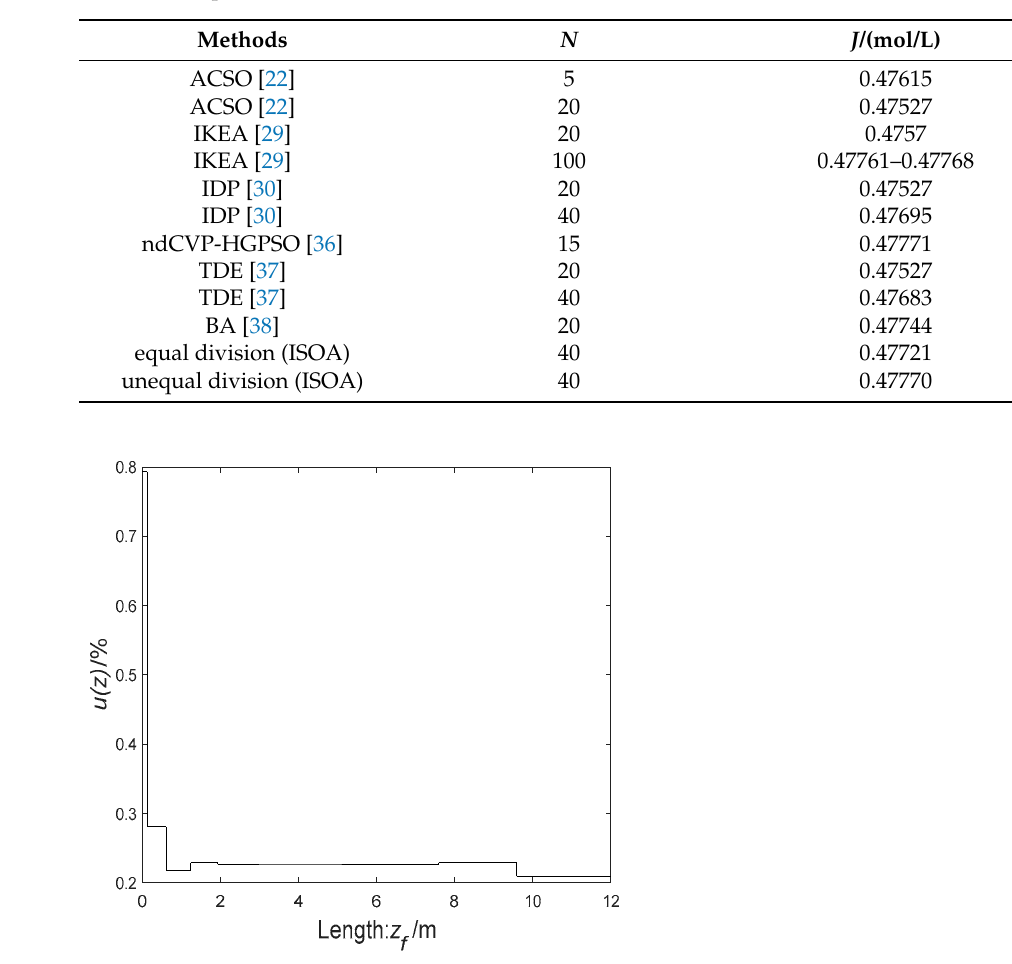
Figure 11. Optimal control trajectory ( N = 20) . Figure 12. Optimal control trajectory ( N = 40).